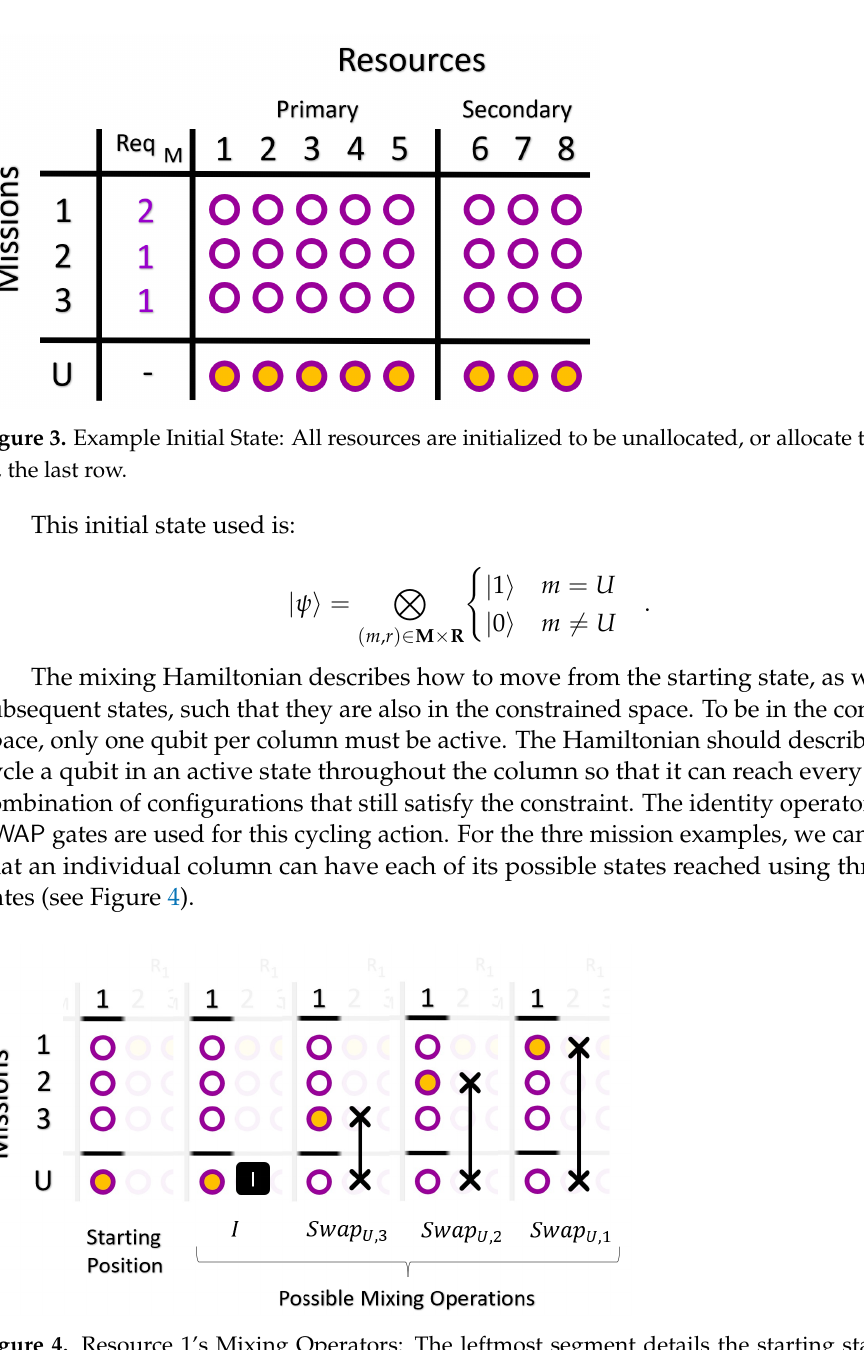
Figure 4. Resource 1’s Mixing Operators: The leftmost segment details the starting state before applying the mixing operator. The second segment from the left shows an identity mixing operator that allows the current state to remain unchanged. The three right-most segments show an operation that uses one swap to cycle the qubit’s on state to missions 1, 2, and